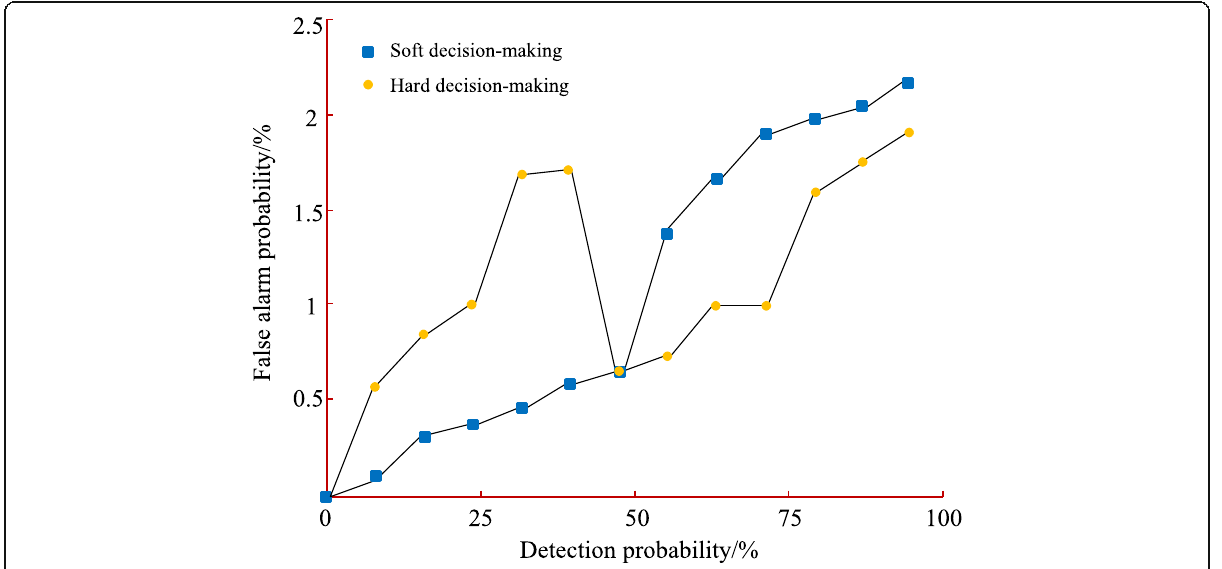
Fig. 6 Comparison of algorithm convergence. The integrated result is shown in Fig. 6